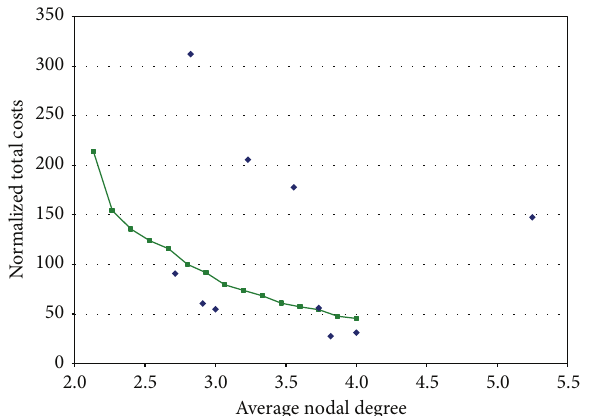
Figure 15: Normalized path restoration JCA total capacity costs.